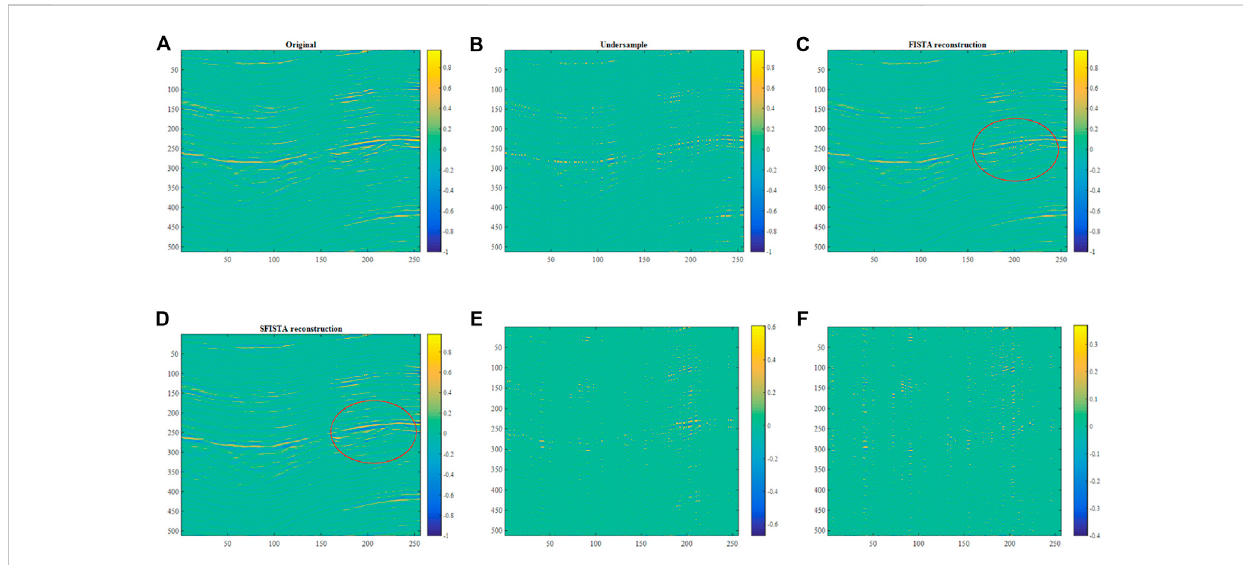
FIGURE 6 Reconstructionresults of fi elddata inthecurvelet domain. (A) Original data; (B) 50% ofrandomlymissing data; (C) interpolateddataobtained bythe FISTA method; (D) interpolated data obtained by the SFISTA method; (E) reconstructed errors obtained by the FISTA method; (F) reconstructed errors obtained by the SFISTA method.